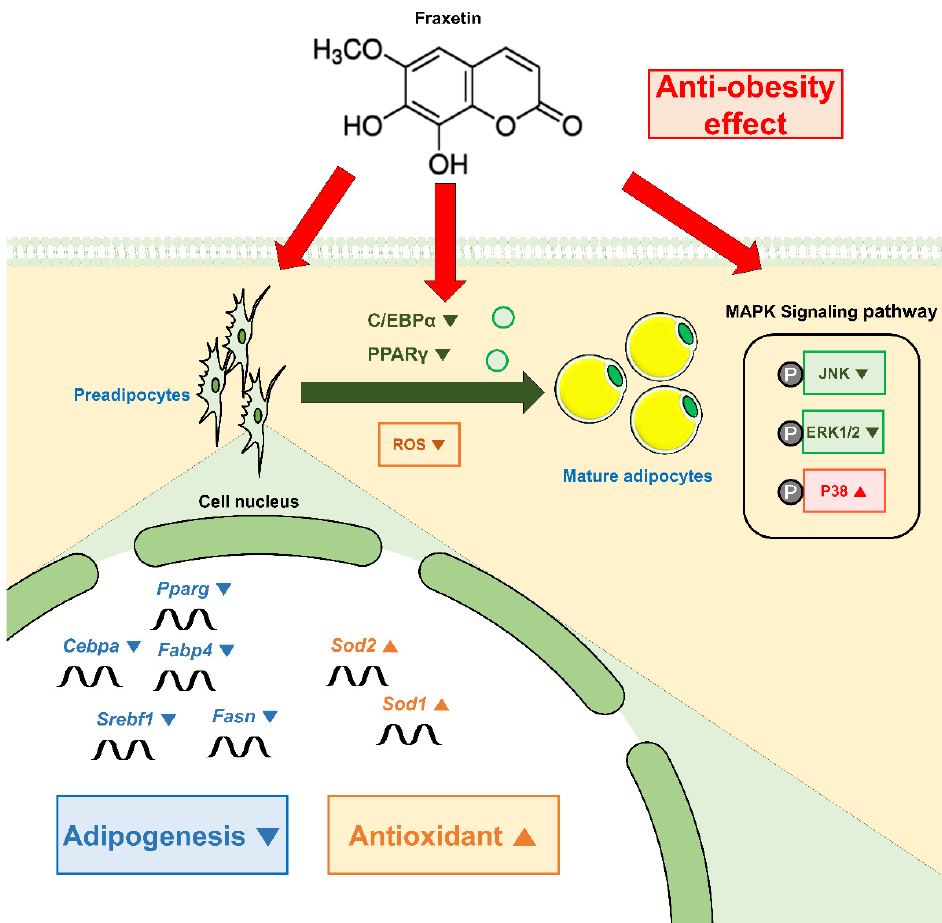
Figure 8. Schematic illustration of fraxetin on 3T3-L1 cells.